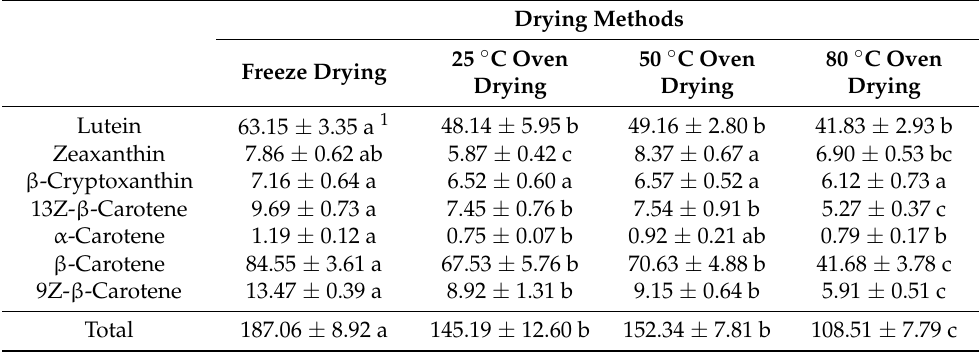
Table 2. The contents of carotenoids in different drying conditions ( µ g/g